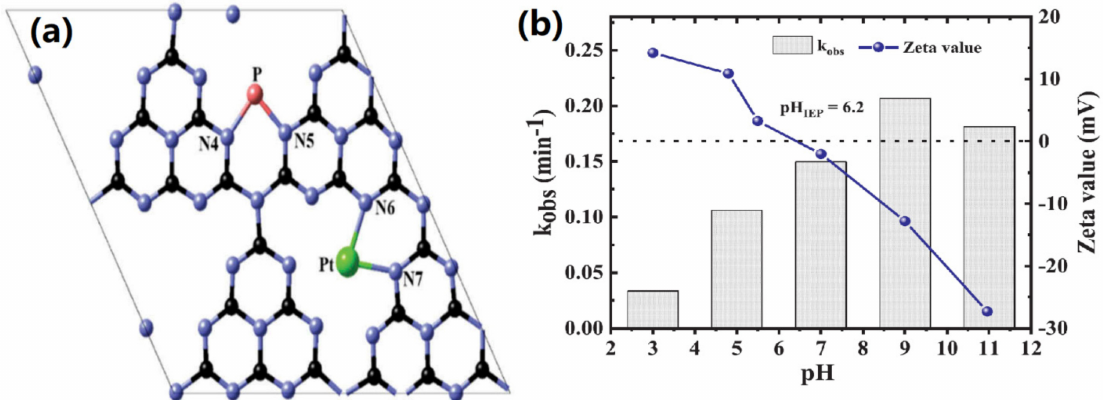
Figure 12. ( a ) The proposed structure of Pt, P-GCN, and ( b ) The SMX photodegradation rate and zeta potential of Ag, P-GCN. Reproduced with permission from Ref.